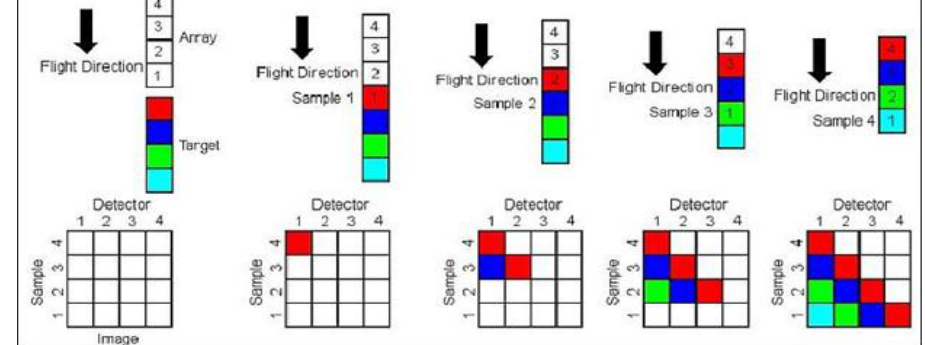
Fig 2. Side-slither imaging process and the image on the